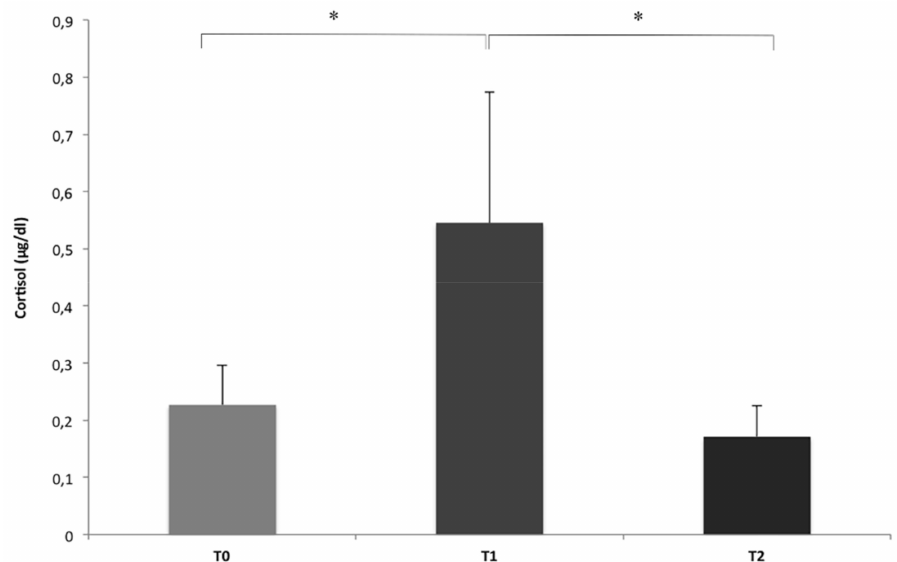
Figure 2. Differences in the mean cortisol levels of dogs collected at T0 (baseline, at the kennel), T1 (after transportation) and T2 (end of AAI sessions) of the five working sessions (means and S.E.M. are shown; Wilcoxon signed rank test). * p <